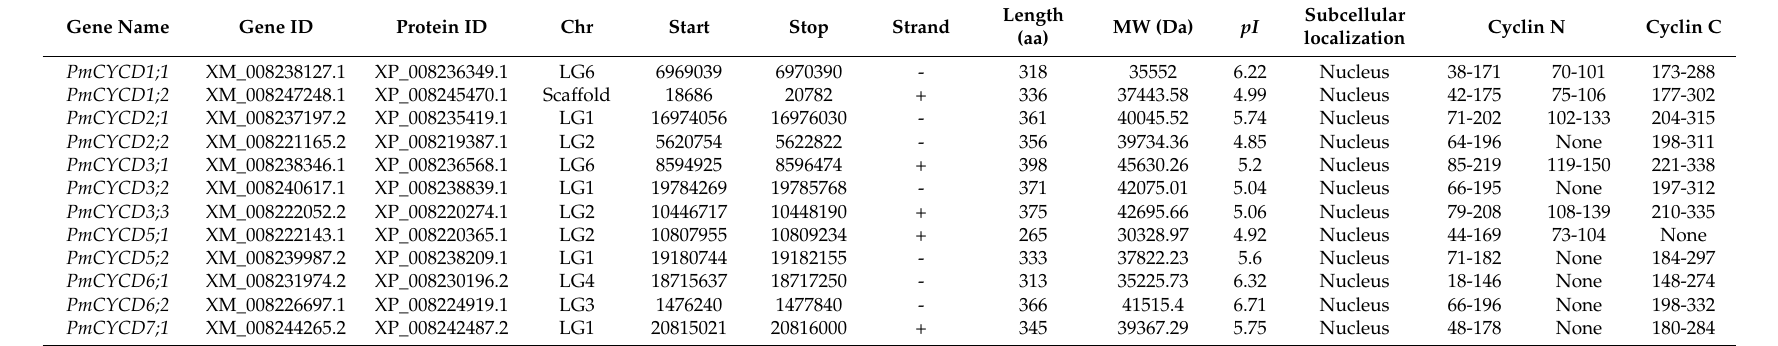
Table 1. Characteristics of the 12 P. mume CYCD ( PmCYCDs ) genes in P. mume